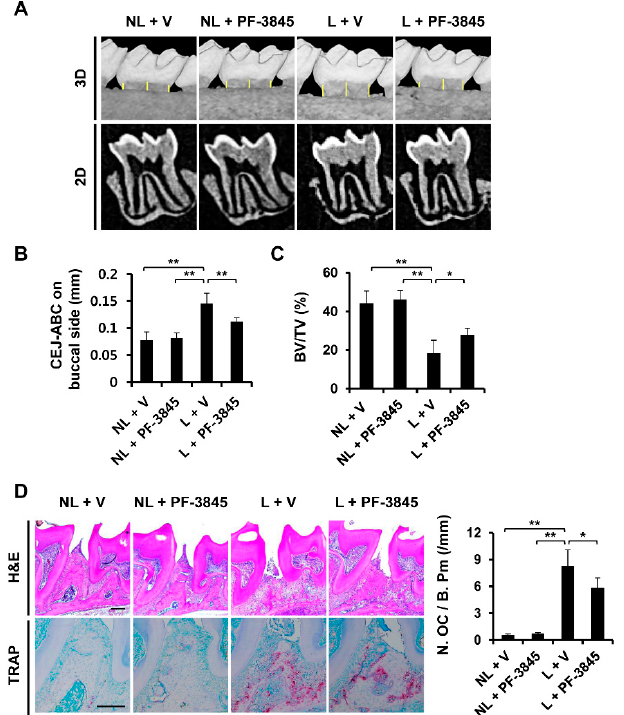
Figure 5. The effect of PF-3845 on alveolar bone loss in mice with experimental periodontitis. ( A ) Three-dimensional and two-dimensional micro-CT images of maxillary second molars in the nonligation with vehicle (NL + V), nonligation with PF-3845 (NL + PF-3845), ligation with vehicle (L + V), and ligation with PF-3845 (L + PF-3845) groups. ( B ) The cementoenamel junction (CEJ)– alveolar bone crest (ABC) distance (indicated by yellow lines) and ( C ) bone volume fraction (BV/TV) were measured. ( D ) The maxillae were decalcified, sectioned, and stained with hematoxylin and eosin (H & E) and TRAP. The number of osteoclasts per bone perimeter [N. OC/B. Pm (/mm)] was measured (right graph). n = 5 in each group. Scale bar, 200 µ m. * p < 0.05, ** p < 0.01 (ANOVA with Tukey’s post